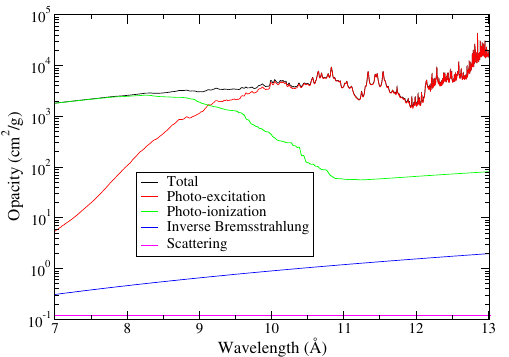
Figure 13. Contributions to the total opacity at T = 182 eV and n e = 3.1 × 10 22 cm − 3 ( ≈ 0.17 g/cm 3 ) computed by SCO-RCG.